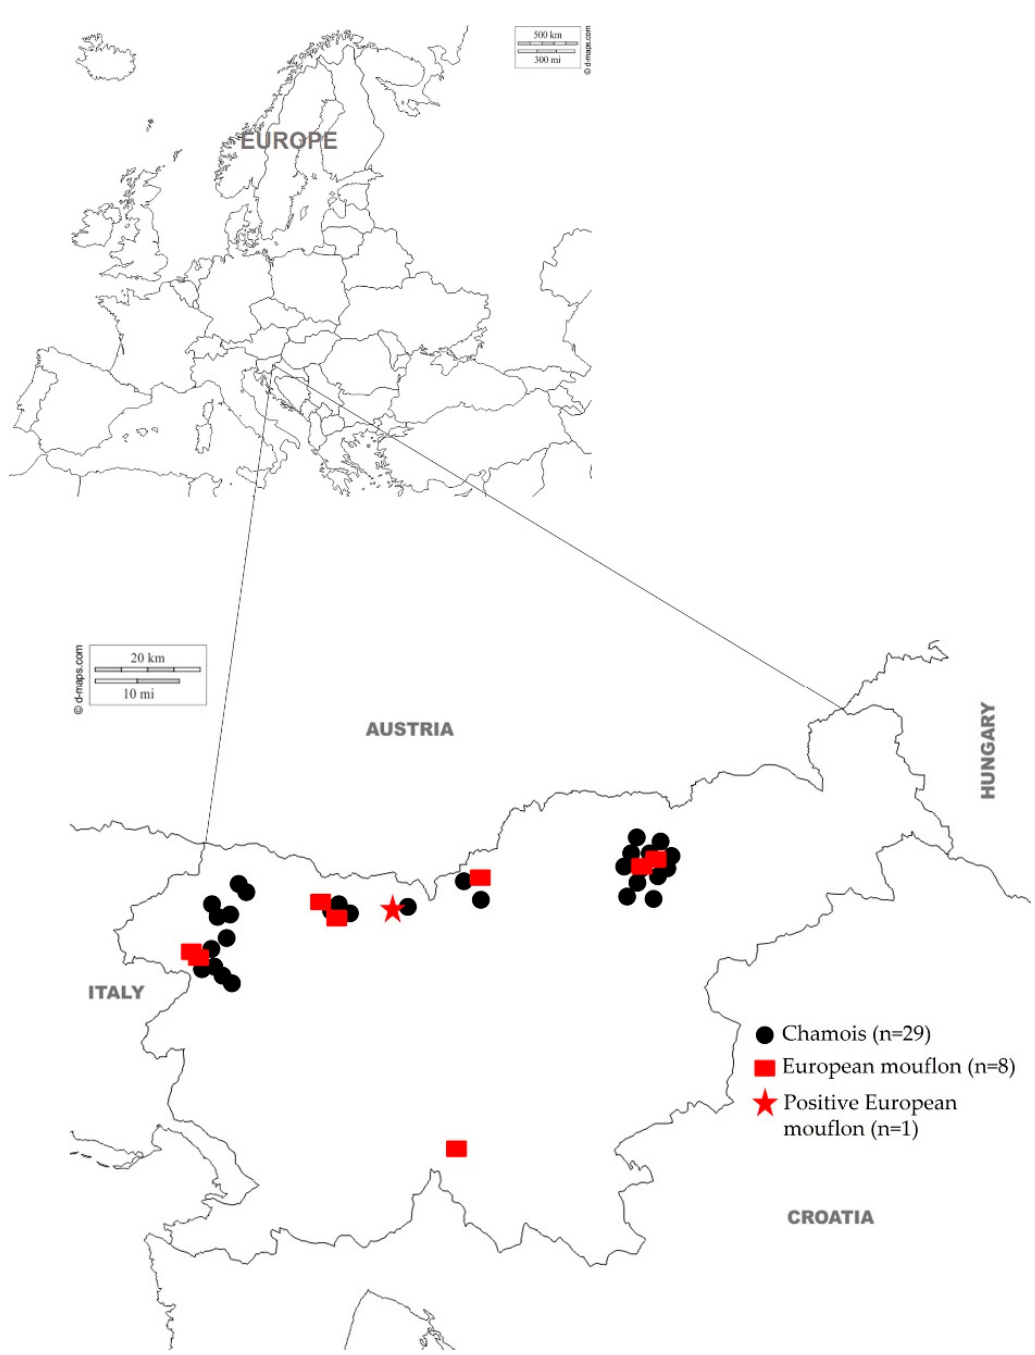
Figure 1. Geographical locations of SRLV antibody-negative and -positive samples from chamois and mouflon in Slovenia tested with ELISA.